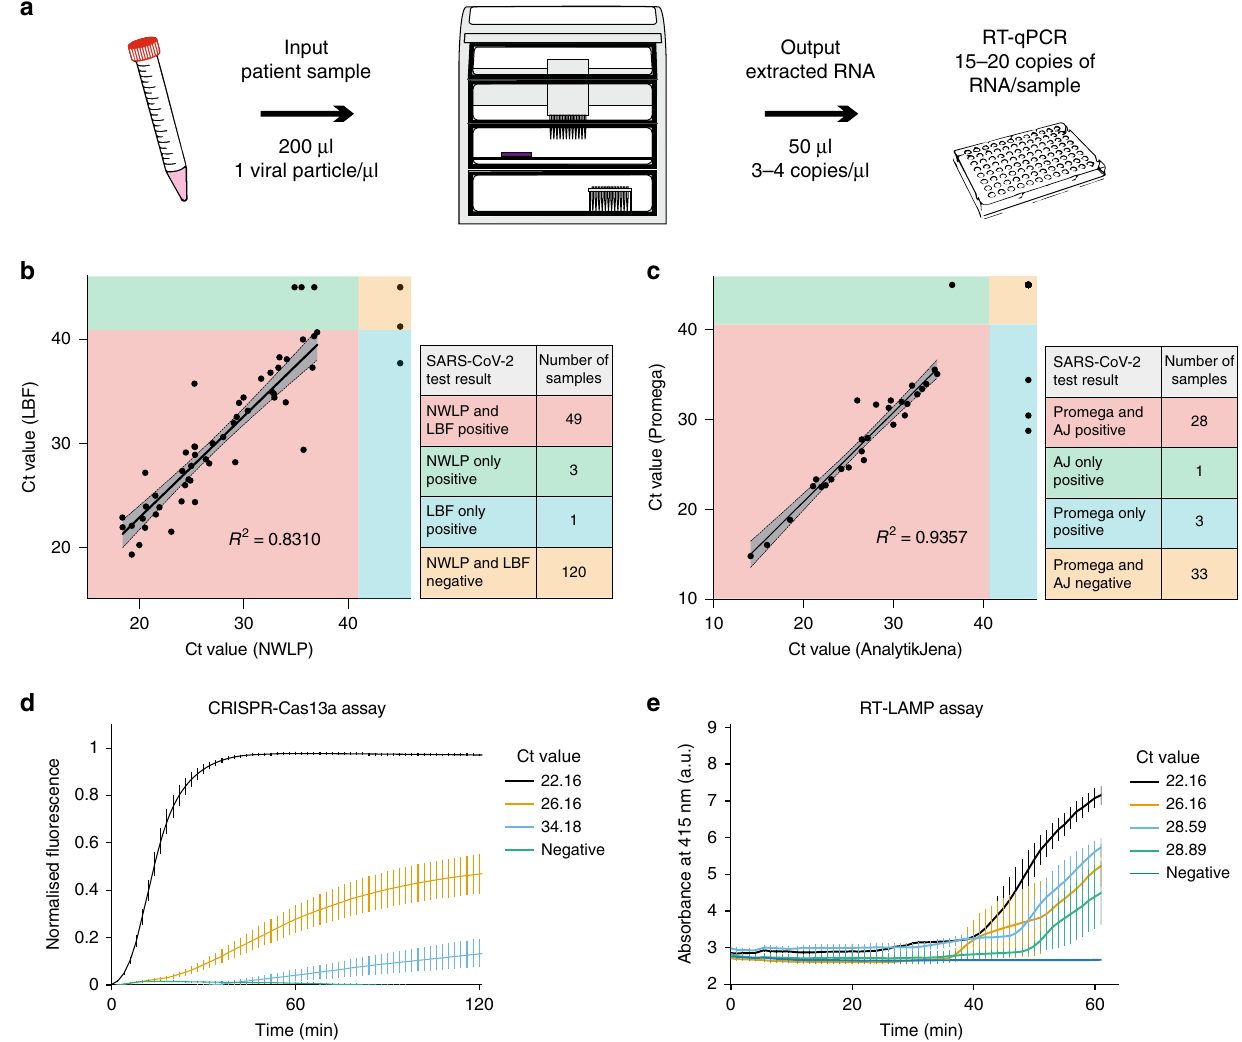
Fig. 5 SARS-CoV-2 platform validation using patient samples. a Schematic of a typical work fl ow tracking viral copy number from a hypothetical patient sample where an input of 200 µ L with a minimum 1 particle/ µ L results in 3 – 4 copies of extracted RNA per microliter resulting in a range of 15 – 20 RNA copies per qPCR reaction. b Comparison of RT-qPCR Ct value results for the same 173 patient samples obtained by the North West London Pathology (NWLP) laboratory and the London Biofoundry (LBF), based on the VLP work fl ow using the Analytik Jena RNA extraction kit and CDC N1 primer – probe set. c Validation of the Promega RNA extraction kit using 65 patient samples with the Analytik Jena RNA extraction work fl ow previously validated in b . Error bands in b and c represent the 95% con fi dence interval. d Validation of the CRISPR NAT using patient samples with Ct values determined via RT-qPCR. Error bars represent the mean ± SE of n = 3 independent ampli fi cation replicates and four technical replicates for CRISPR detection. e Validation of the RT- LAMP colorimetric NAT using patient samples with Ct values determined via RT-qPCR. Error bars represent the mean ± SE of n = 3 independent ampli fi cation reactions. Source data are available in the Source Data fi